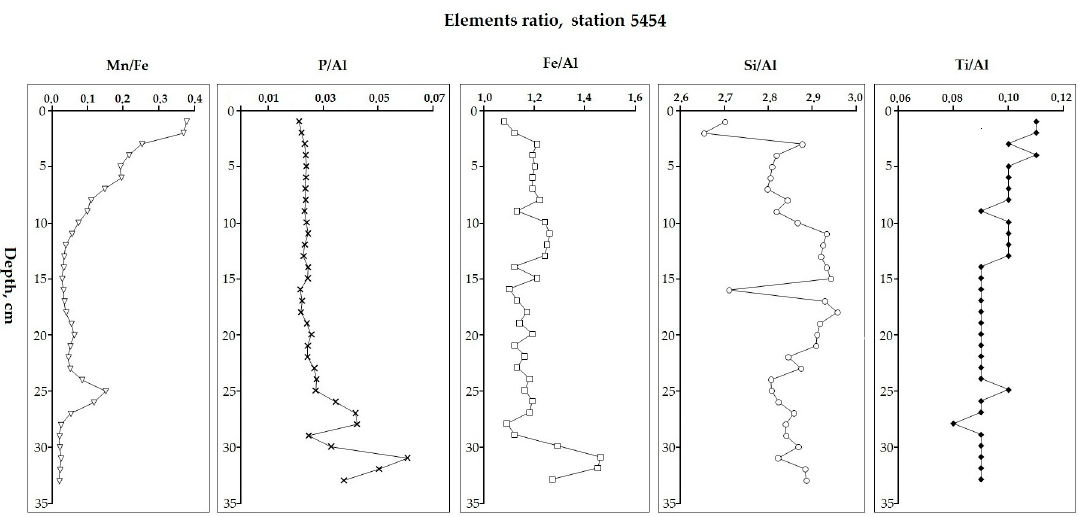
Figure 12. The elemental ratios down the core AMK-5454, the Cambridge Strait, the Franz Josef Land Archipelago. Dotted line means element ratio’s average for the core.